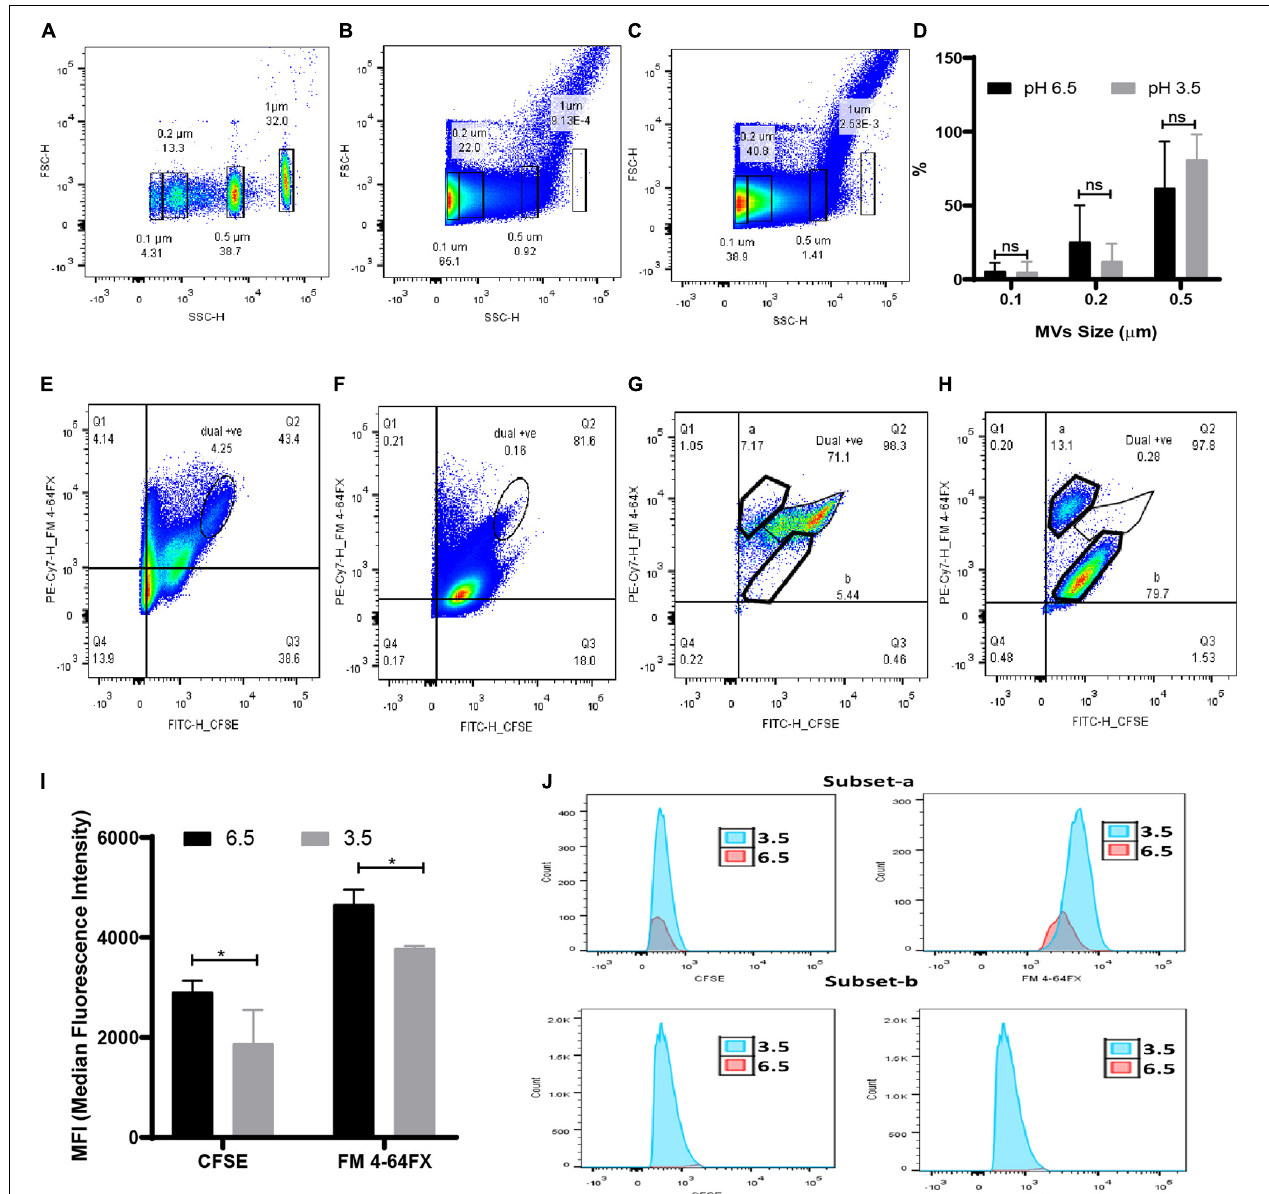
FIGURE 4 | Quantitation of MVs at submicron level under acidic condition by flow cytometry. (A) Forward vs side scatter profile of FITC tagged sub-micron beads (0.1, 0.2, 0.5, and 1 µ m). Representative scatter profile of protein (CFSE) and lipid stained (FM 4-64FX) MVs of (B) pH 6.5 and (C) pH 3.5 superimposed with reference beads gate. (D) Change in percentage of MVs of varying sizes at pH 6.5 and pH 3.5 corresponds to the superimposed gates on scatter plot of pH 6.5 and pH 3.5 MVs. Data are presented as mean ± SD ( n = 3). Quadrant gate, Q2 represents dual positive population of 0.5 µ m sized MVs of (E,G) pH 6.5 and (F,H) pH 3.5 and two sub population at (G) pH 6.5 and (H) pH 3.5. (I) Median Fluorescence intensity of dual positive population of CFSE and FM 4-64FX stained MVs (* p < 0.05). (J) Histograms of a and b subsets of pH 6.5 and 3.5